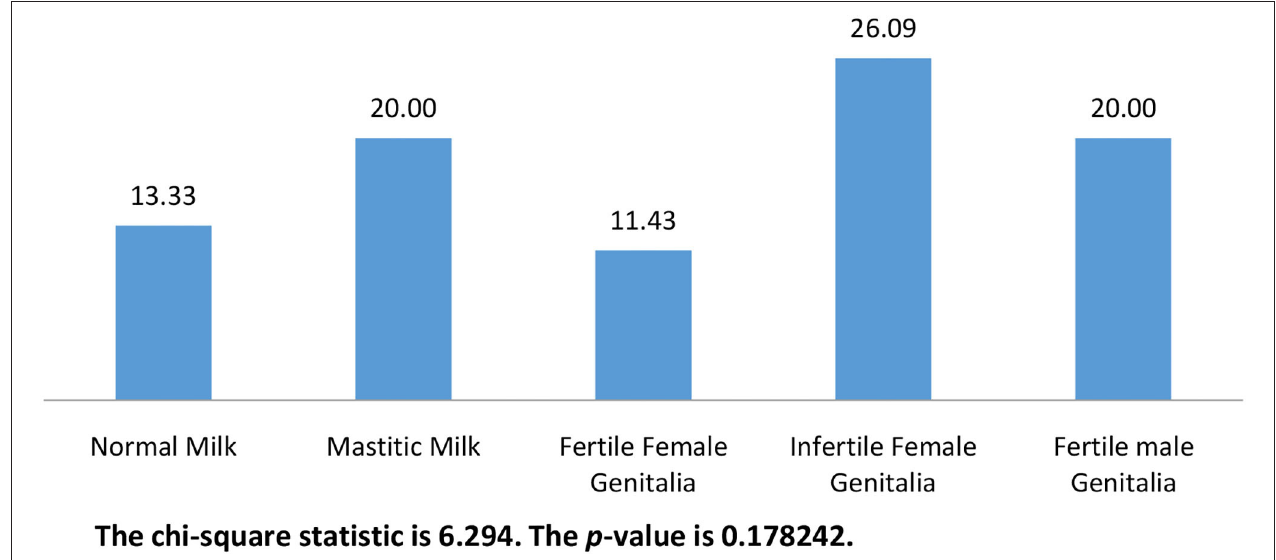
FIGURE 1 | The frequency of isolation of C. albicans from different animal groups ( n = 240).